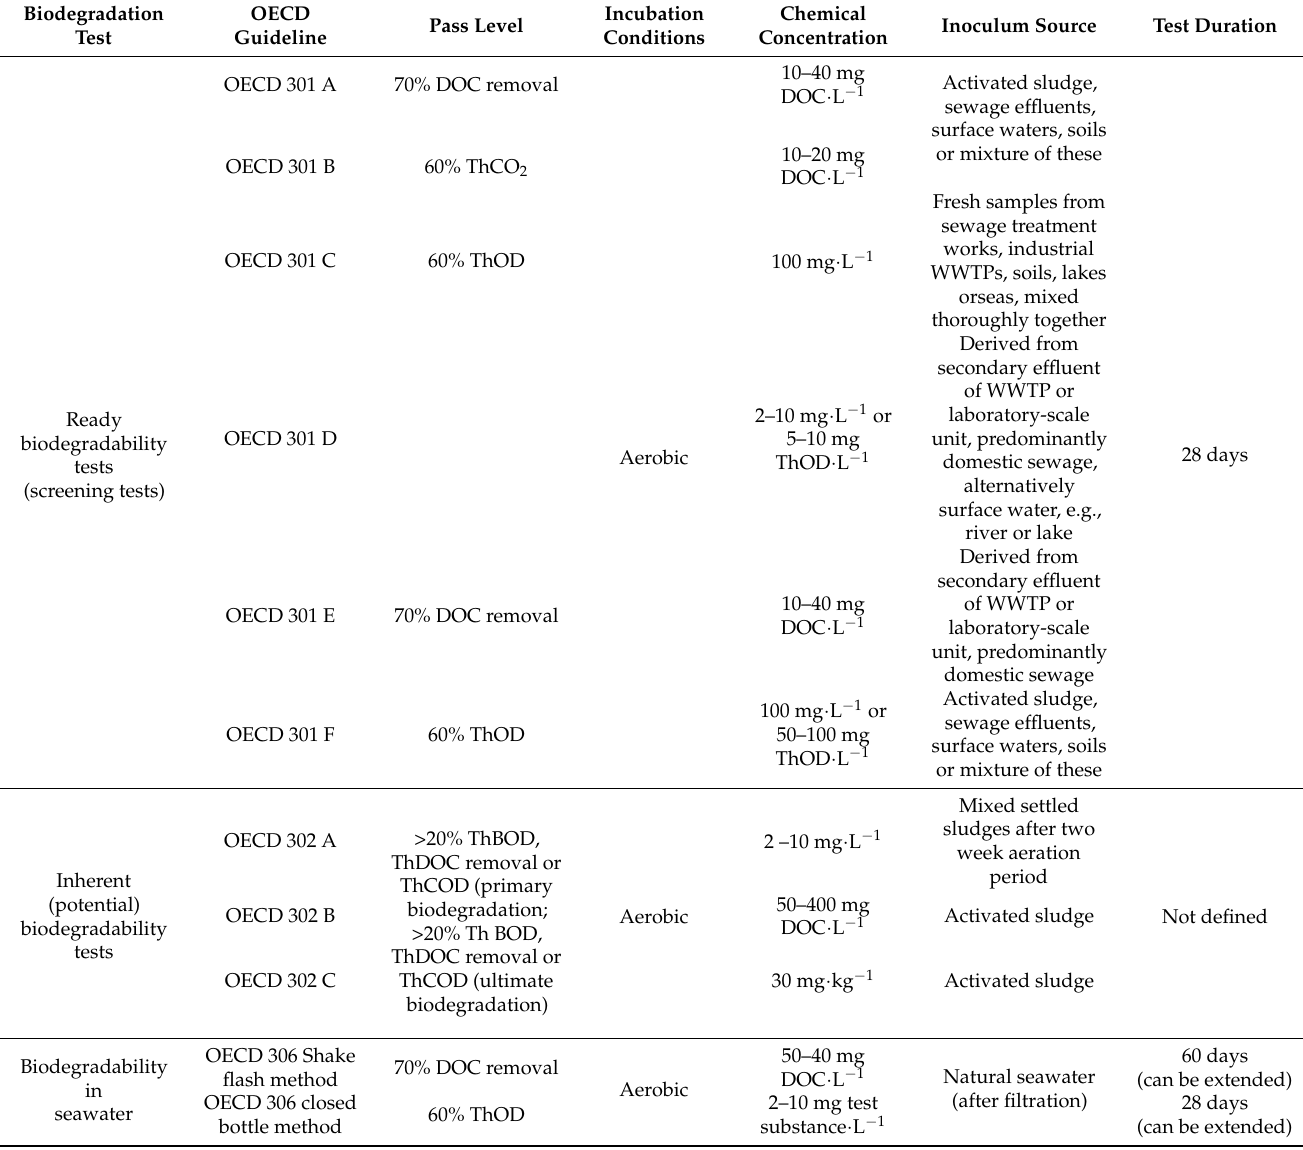
Table 2. Overview of OECD biodegradation